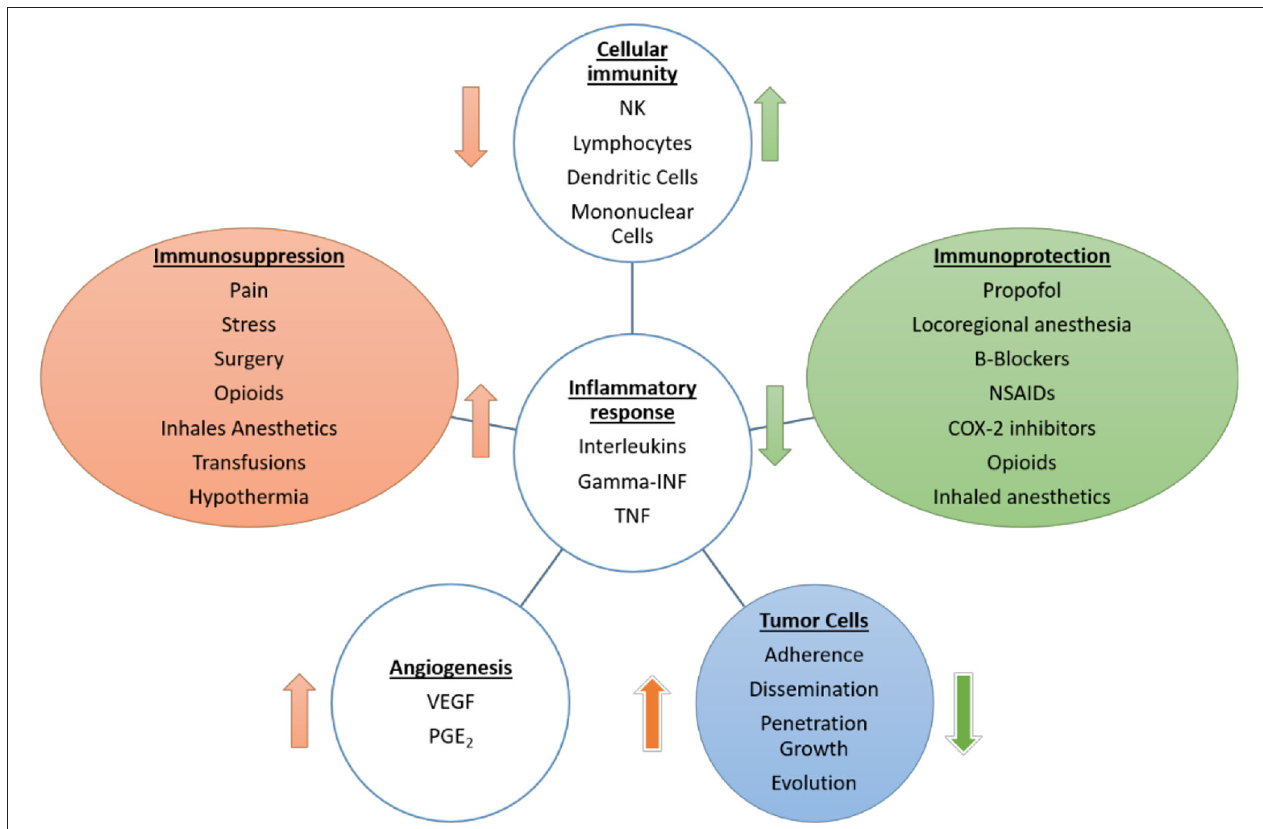
FIGURE 1 | Effects of anesthetic drugs, surgery, and other perioperative factors on cellular immunity, inflammatory response, and angiogenesis as mechanisms involved in metastatic development. The scheme reflects the deleterious effect on the immune system and the increase in the inflammatory and proangiogenic response by factors, such as surgery, opioids, or inhaled